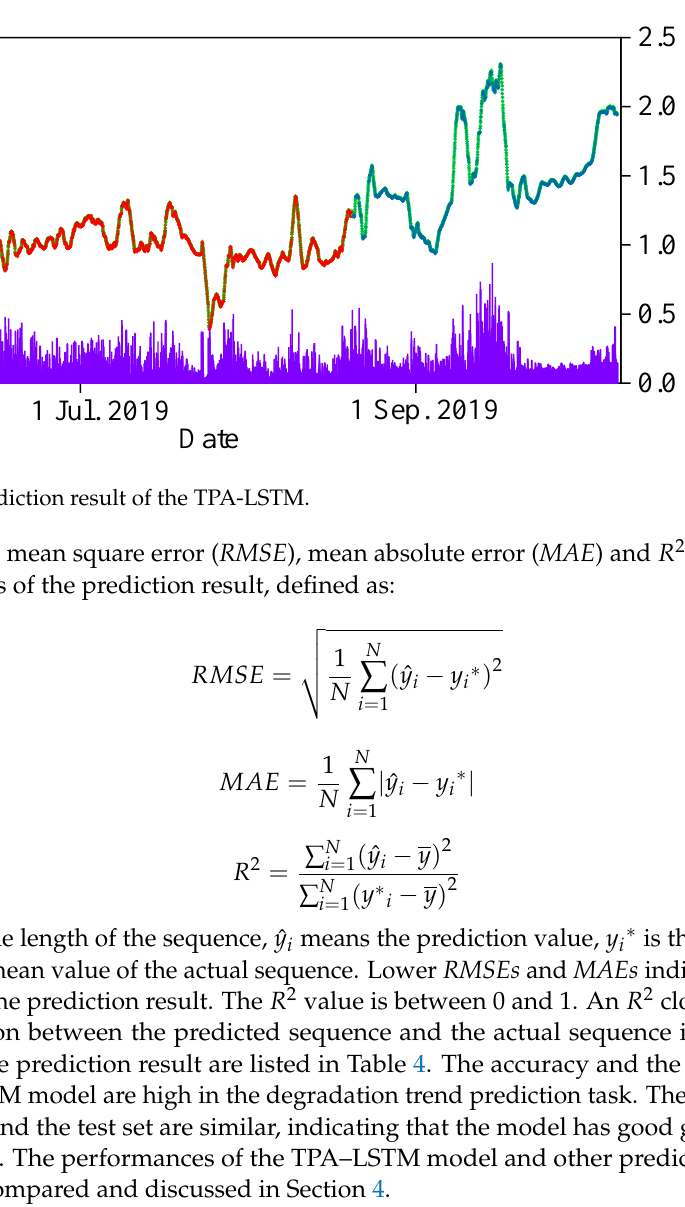
Table 4. Criteria of the prediction result.